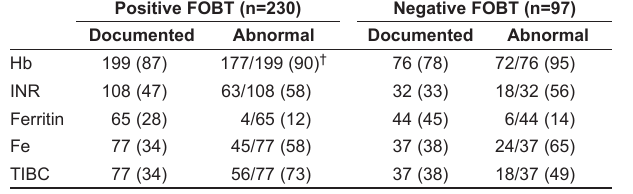
TAble 4 percentage of documented and abnormal* laboratory